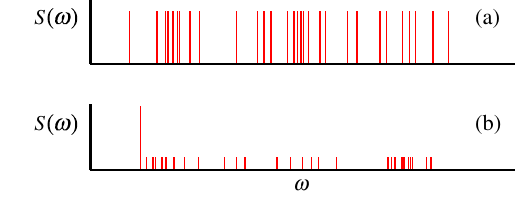
FIG. 1. Parametrizations of the spectral function used in this work. In diagram (a), a large number of δ functions with the same amplitude occupy frequencies ω practice, on a very fine frequency grid). The locations are sampled in the SAC procedure. In diagram (b), the δ function at the lowest frequency ω 0 has a larger amplitude, a 0 > a i > 0 , and this amplitude is optimized in the way described in the text. The frequencies of all the δ functions, including ω 0 , are sampled as in (a) but with the constraint ω 0 < ω